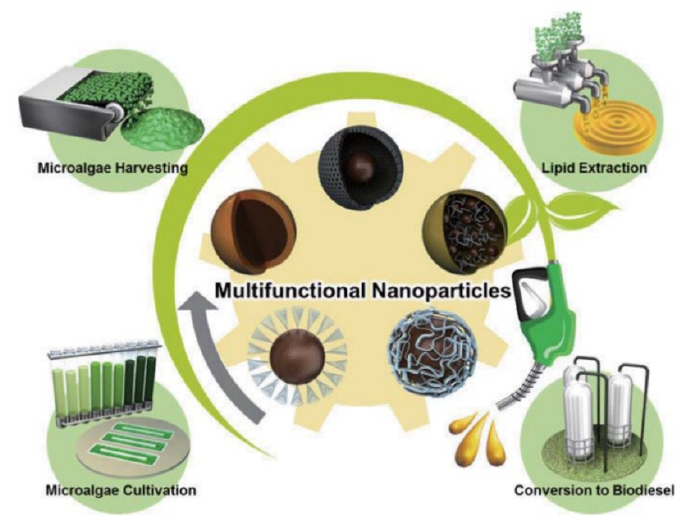
Figure 6. A schematic illustration of utilization of multi-functional nanoparticles in algal biorefinery process development. Reprinted from Reference [122] with permission from Springer International